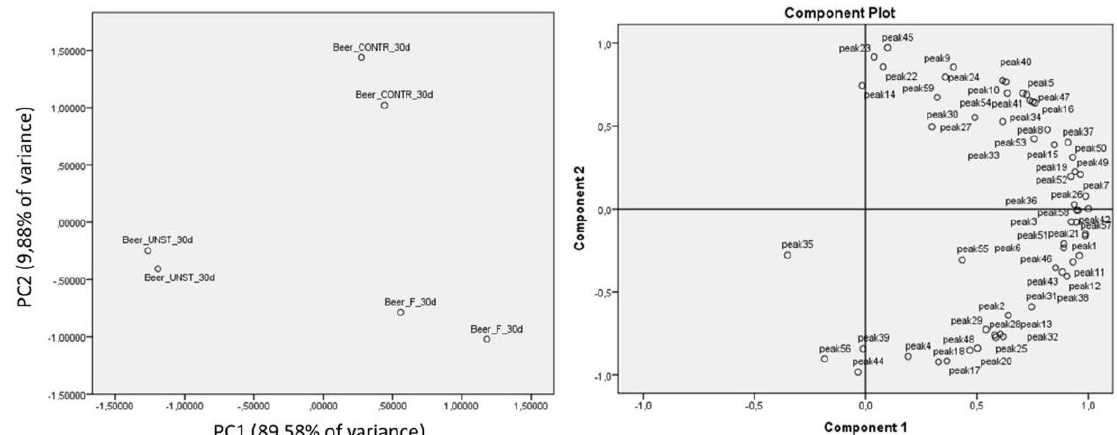
Figure 4. Principal component analysis (PCA) of beer and flavored beer. Scatter plot of scores from PC1 versus PC2 obtained using the concentrations (ppm) of the 59 different detected volatile compounds observed for beer samples analyzed after 30 days of maturation, and the relative loadings of the variables used. Beer CONTR: Beer with no added apple pomace; Beer UNST: beer with added unstarted apple pomace; Beer F: beer with added Lactobacillus rhamnosus 1473 fermented heated apple pomace; analyzed at 30 days of maturation.